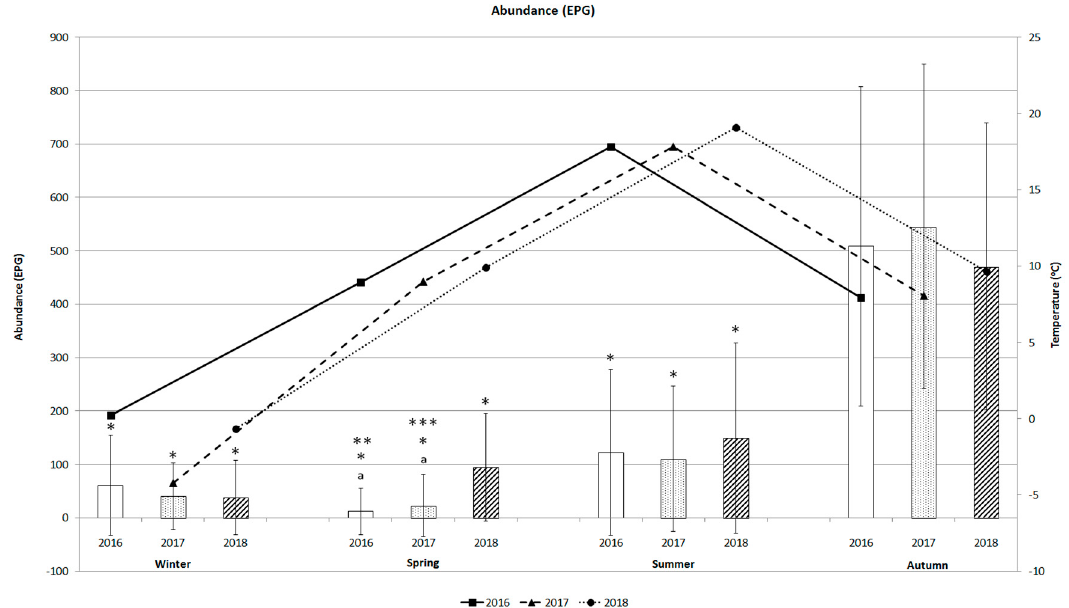
Figure 3. Abundance (mean EPG) of B. transfuga eggs in the faecal samples of the brown bear ( Ursus arctos ) and mean temperature (°C) during different seasons of the three-year survey; a significant difference between spring 2016 and 2017, and spring 2018, p < 0.0001; *, significant differences between autumn and winter, spring, and summer 2016, 2017, and 2018; p < 0.0001; **, significant difference between spring and summer 2016, p < 0.005; ***, significant difference between spring and summer 2017, p < 0.05.